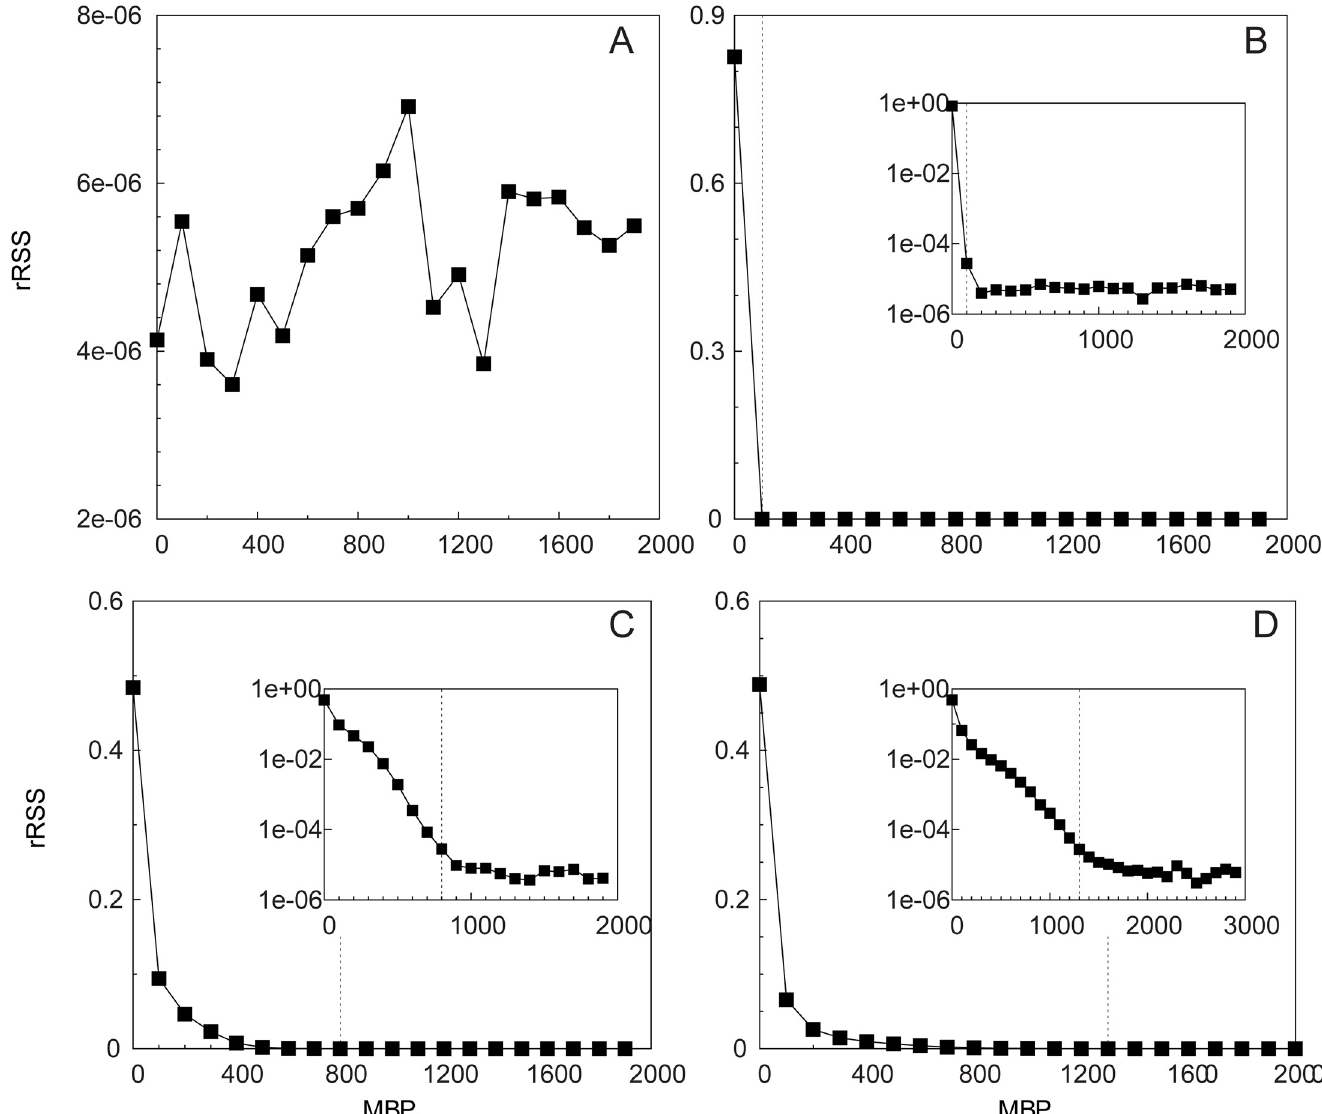
Fig 2. Scenario 1: Renormalized sum of squared residuals. The rSSR is calculated among pairs of survival curves of residence times with Δ MBP = 100 and different values of the noise parameter: η = 1 (A), 0.1 (B), 0.01 (C) and 0.005 (D). The vertical dashed line represent the MBP value at which the survival curve of residence times mostly approached the theoretical curve. Insets: the same in semi-logarithmic scale.